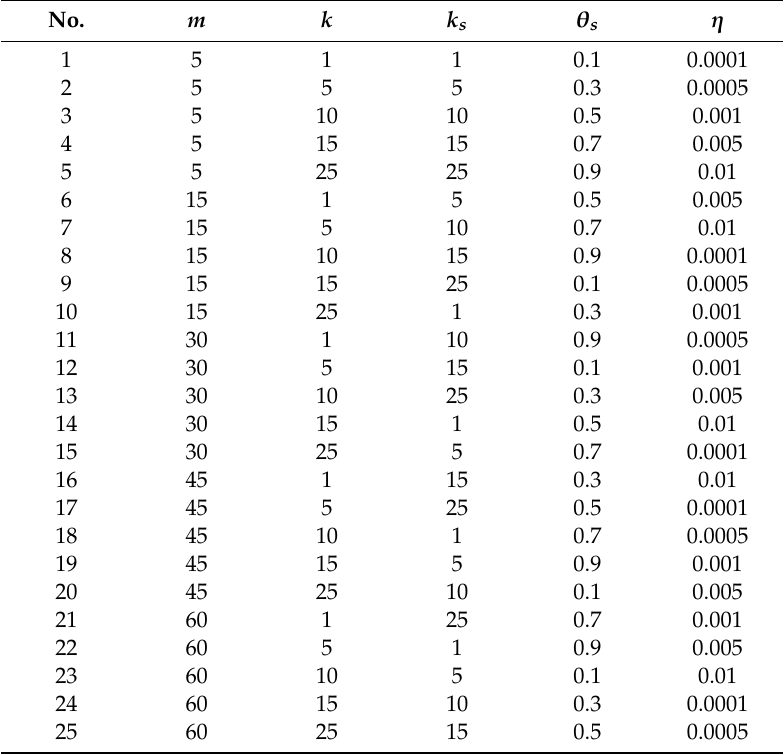
Table 8. Parameter combination of